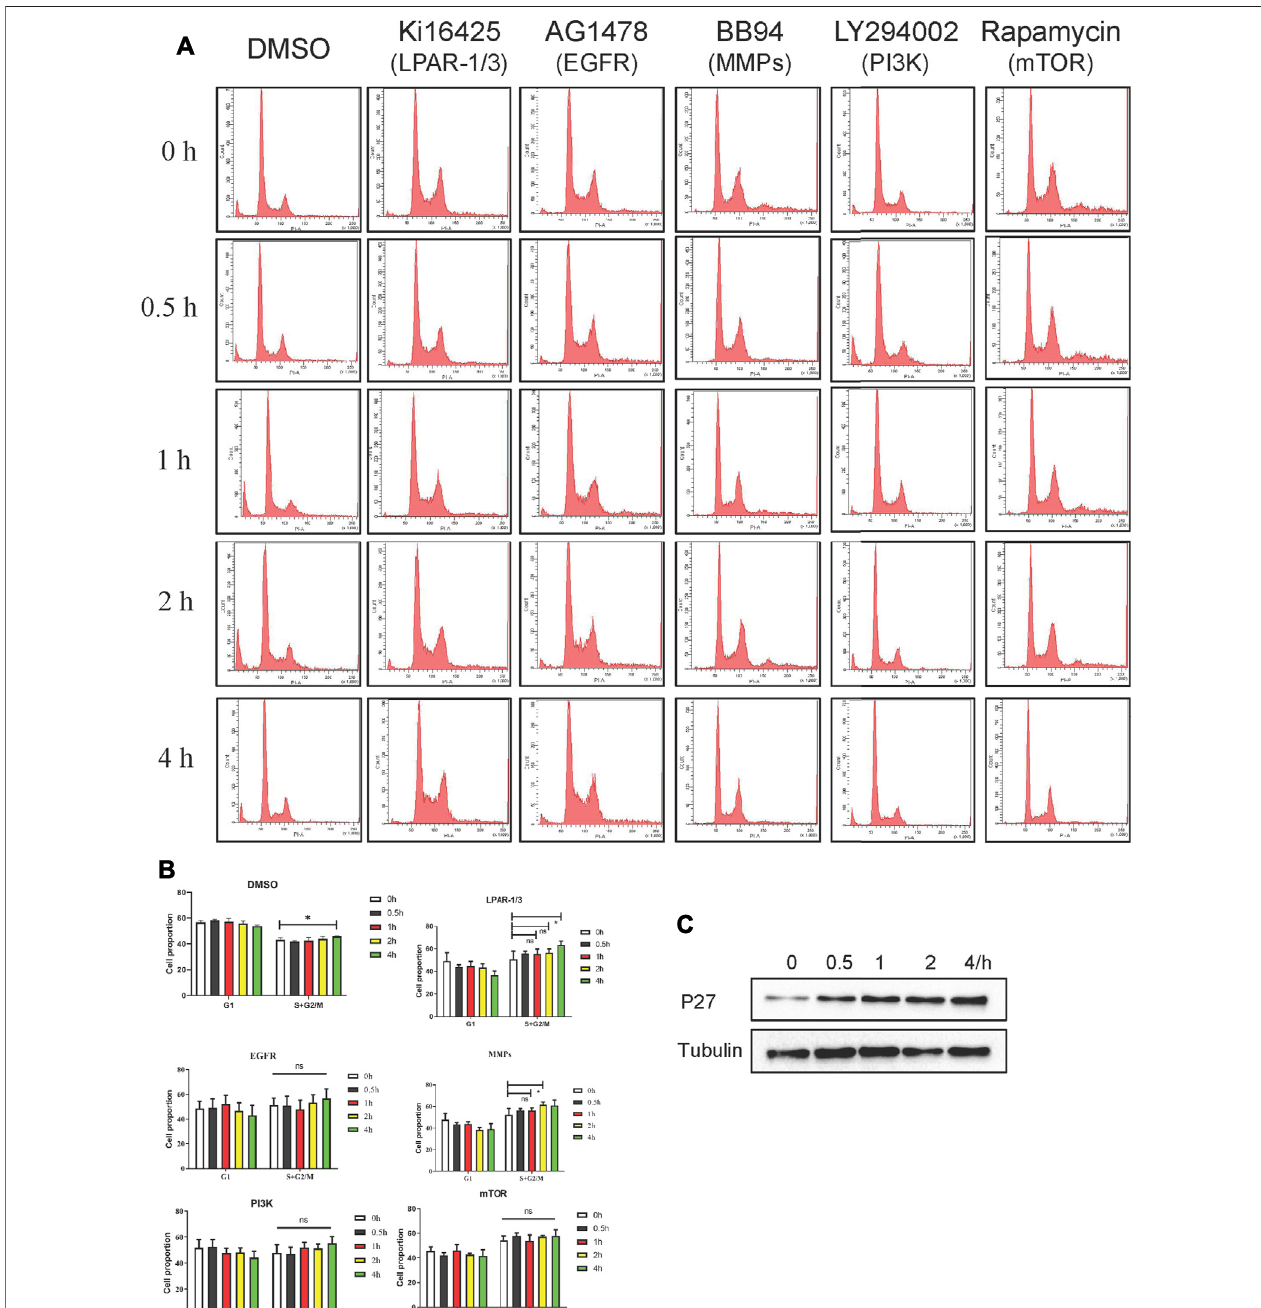
FIGURE 7 | LPA induces S phase cell-cycle progression through LPAR 3 /MMP S /EGFR/PI3K/mTOR signaling axis in MKN45 cells. (A) Quiescent cells were pretreated with DMSO (vehicle 0.1%), Kil6425 (10 µM), BB94 (10 µM), AG1478 (250 nM), LY294002 (10 µM), or rapamycin (100 nM) for 30 min and stimulated with 10 µM LPA up to 4 h. After the treatment, the cells were harvested and stained with PI to analyze the quality of DNA content by FACS analysis. (B) Quali fi cation of DNA contentin (A) ,mean ± SD, n (cid:2) 3.* p < 0.05,ANOVAtest andDunette ’ smultiplecomparisons testwereusedfordataanalysis. (C) Expressionofp27afterLPAtime grade